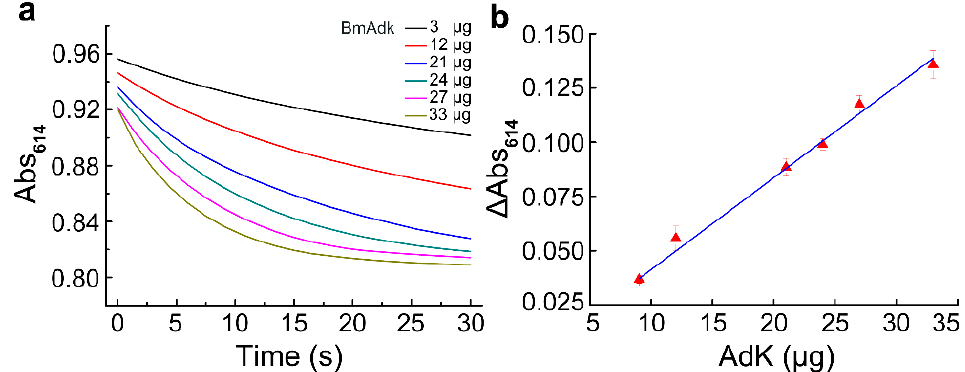
Figure 3. The effect of Adk contents on the assay. ( a ) Effect of different Adk contents on the assay; ( b ) the correlation of the absorbance change of bromothymol blue at 614 nm with different Adk contents.